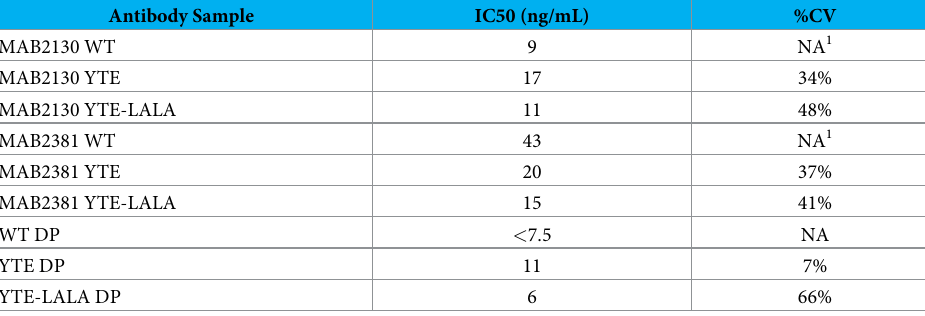
YTE DP: MAB2130 YTE combined with MAB2381 YTE